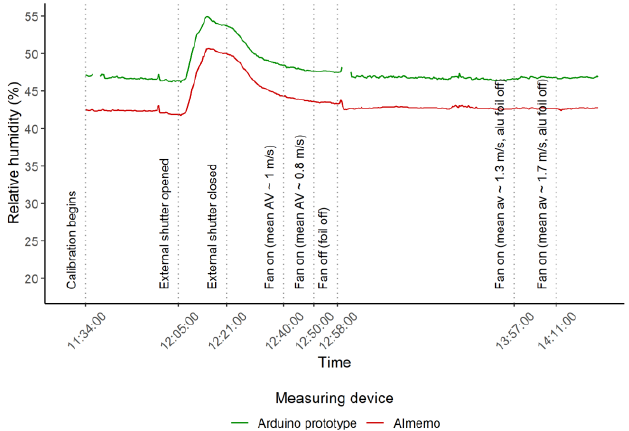
Figure A3. Relative humidity recorded by the Arduino prototype and Almemo instrument during various ambient conditions.